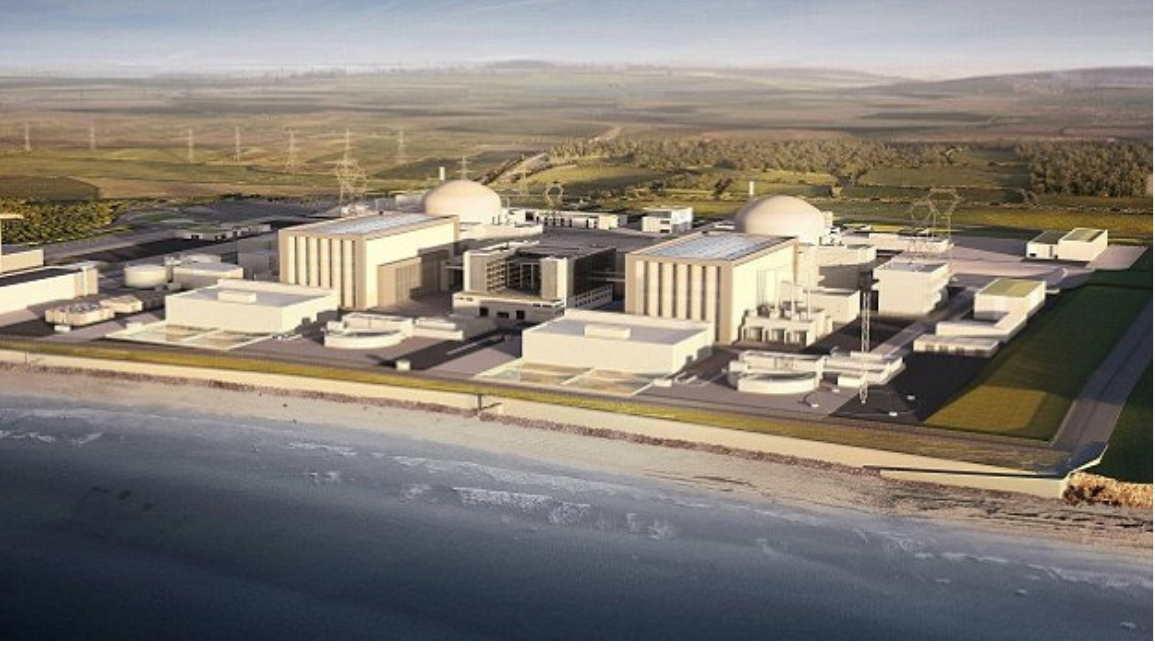
Figure 1. Computer-generated View of the Completed HPC